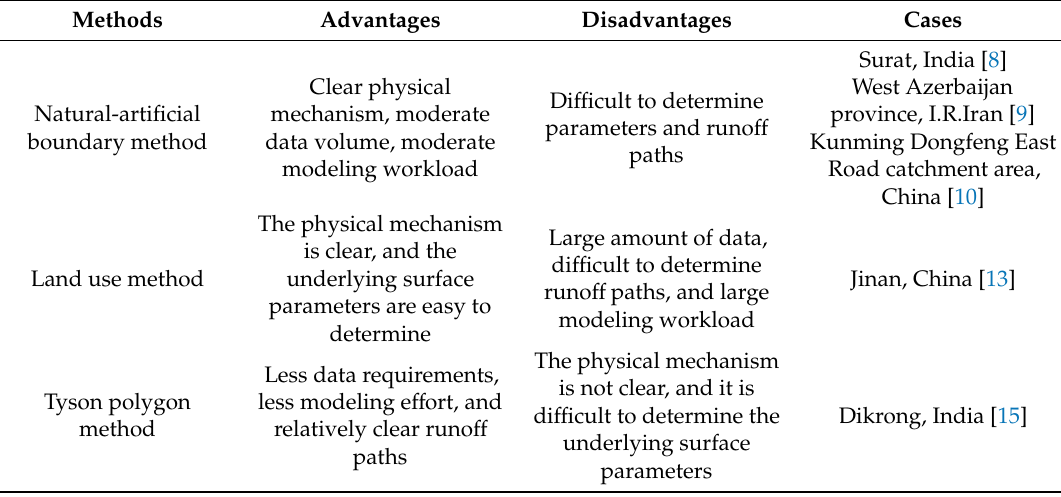
Table 1. Main division methods of subcatchments and their advantages and